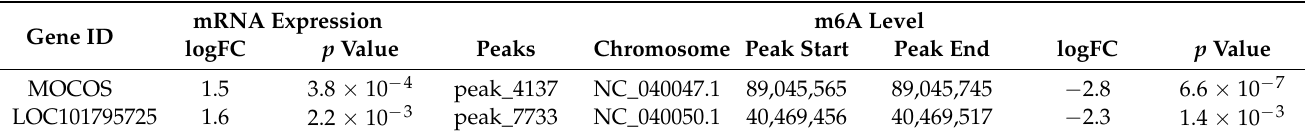
Table 5. List of hypo-up methylated genes that were significantly different between E19 and